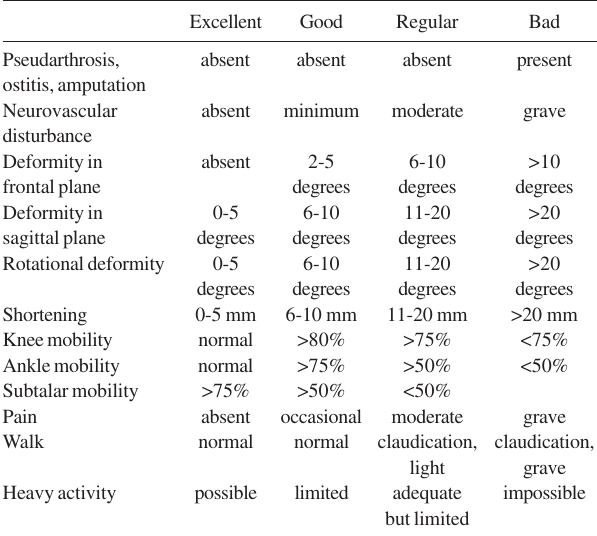
Table 2 - Tibia fracture classification scheme (Johner and Wruhs, 1983)